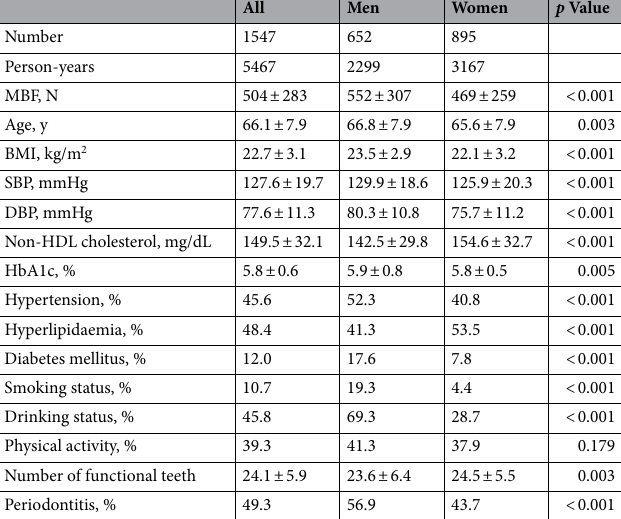
Tables 2 and 3 show the baseline characteristics of the study subjects by MBF quintiles separately for men and women. In both men and women, groups with higher MBF were significantly younger and had significantly